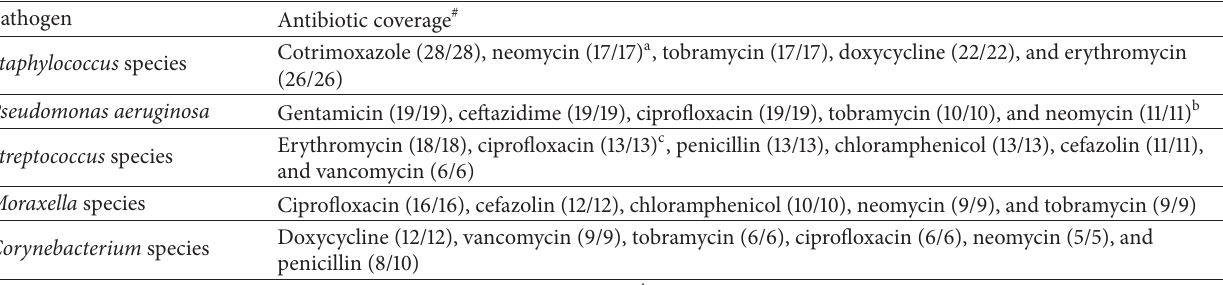
Table 3: Antibiotic coverage against the most commonly isolated bacteria. Pathogen Antibiotic coverage # Staphylococcus